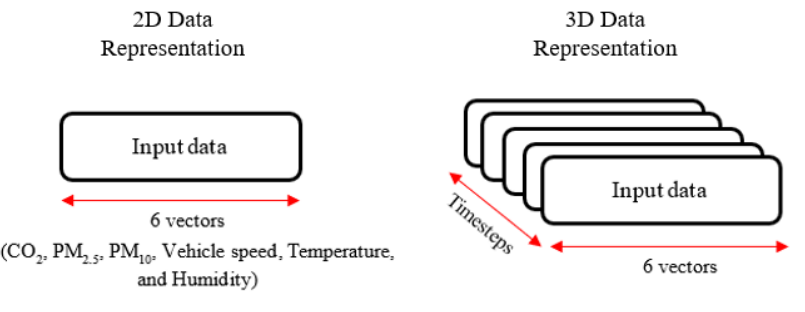
Figure 6. Input Data Representation.